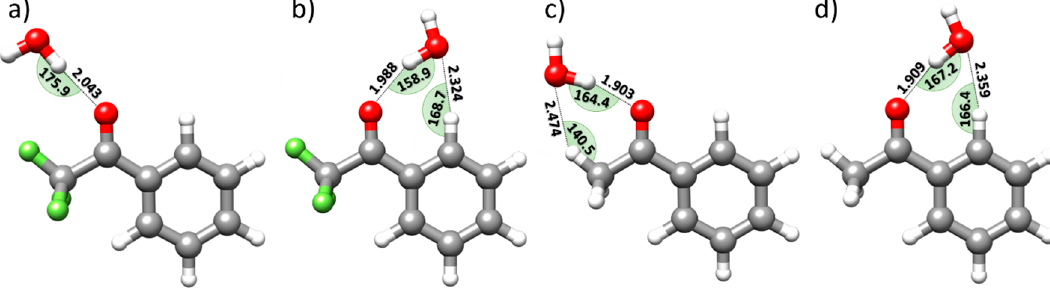
Figure 5. rDSDjun structures of the isomer II ( a ) and isomer I ( b ) of TFAP-W and of the isomer I ( c ) and isomer II ( d ) of AP-W. The parameters involved in the corresponding HBs are also reported (bonds are expressed in Å and angles in degrees).